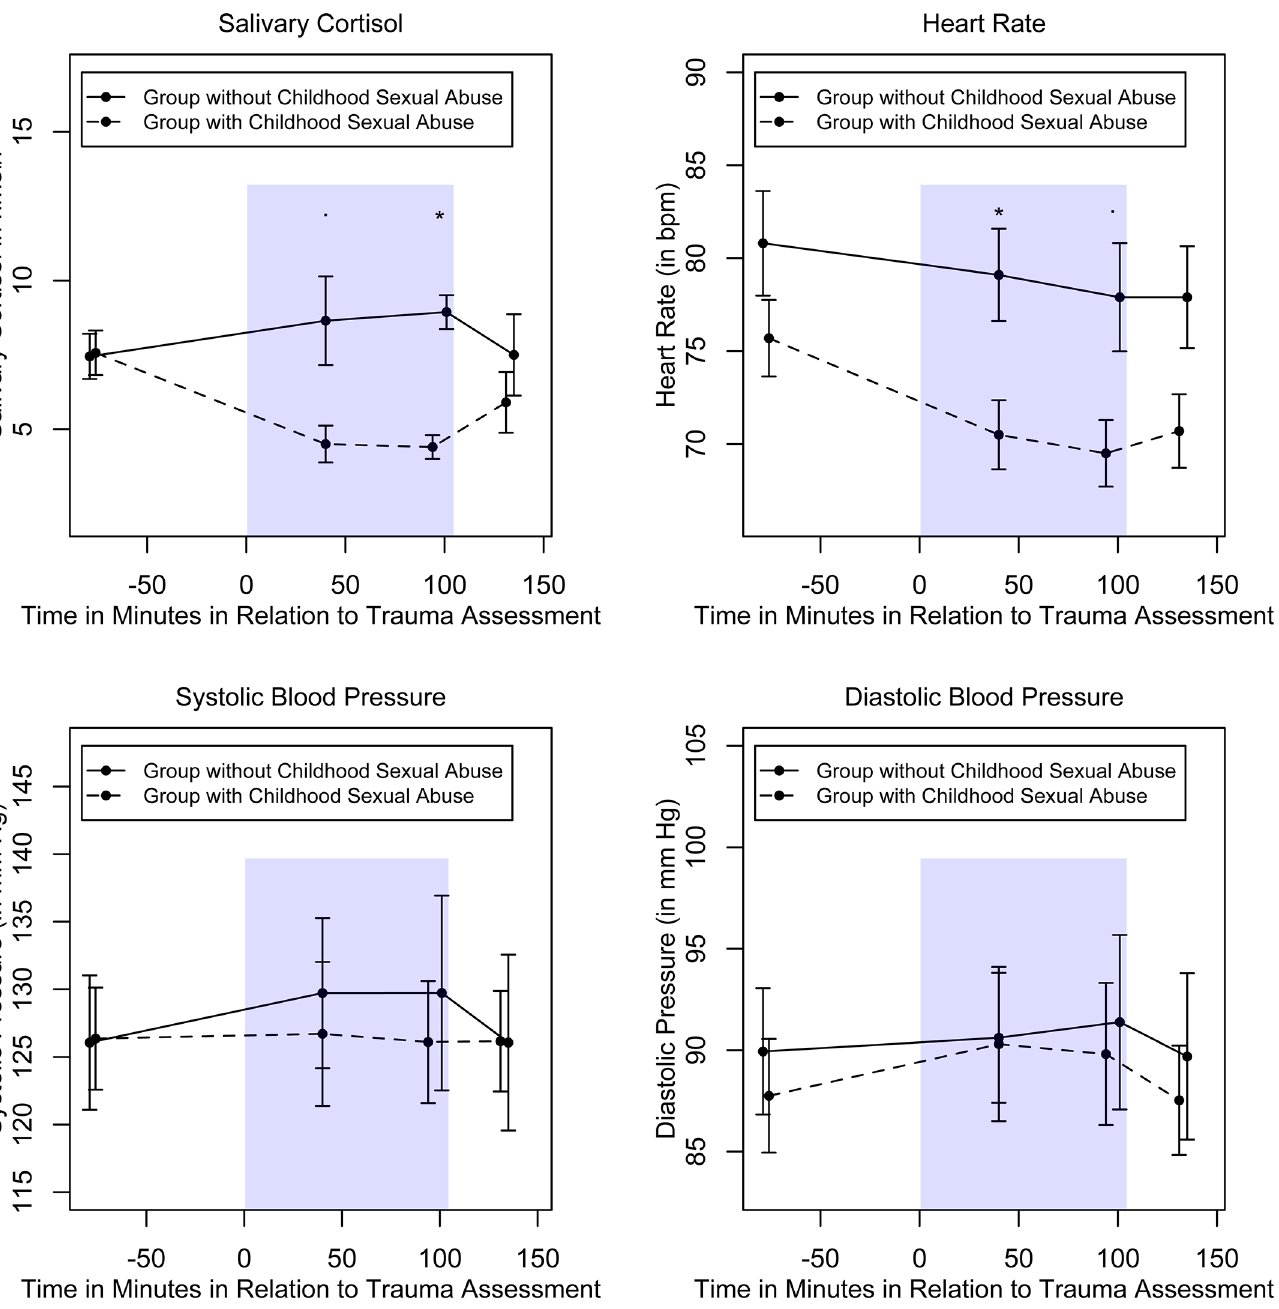
Fig 2. Salivary Cortisol, Heart Rate and Blood Pressure across the Interview as a Function of Group (with and without Childhood Sexual Abuse). The mean reactivity of saliva cortisol (in original non-log-transformed units), heart rate and blood pressure response separately for the group with and without childhood sexual abuse. The error bars indicate the standard error of the mean ( SEM ). The blue-shaded area marks the average time of trauma assessment. “ * ” indicates significant group difference at p (cid:1) .050, and “ (cid:3) ” at p (cid:1) .10 (with Bonferroni correction)